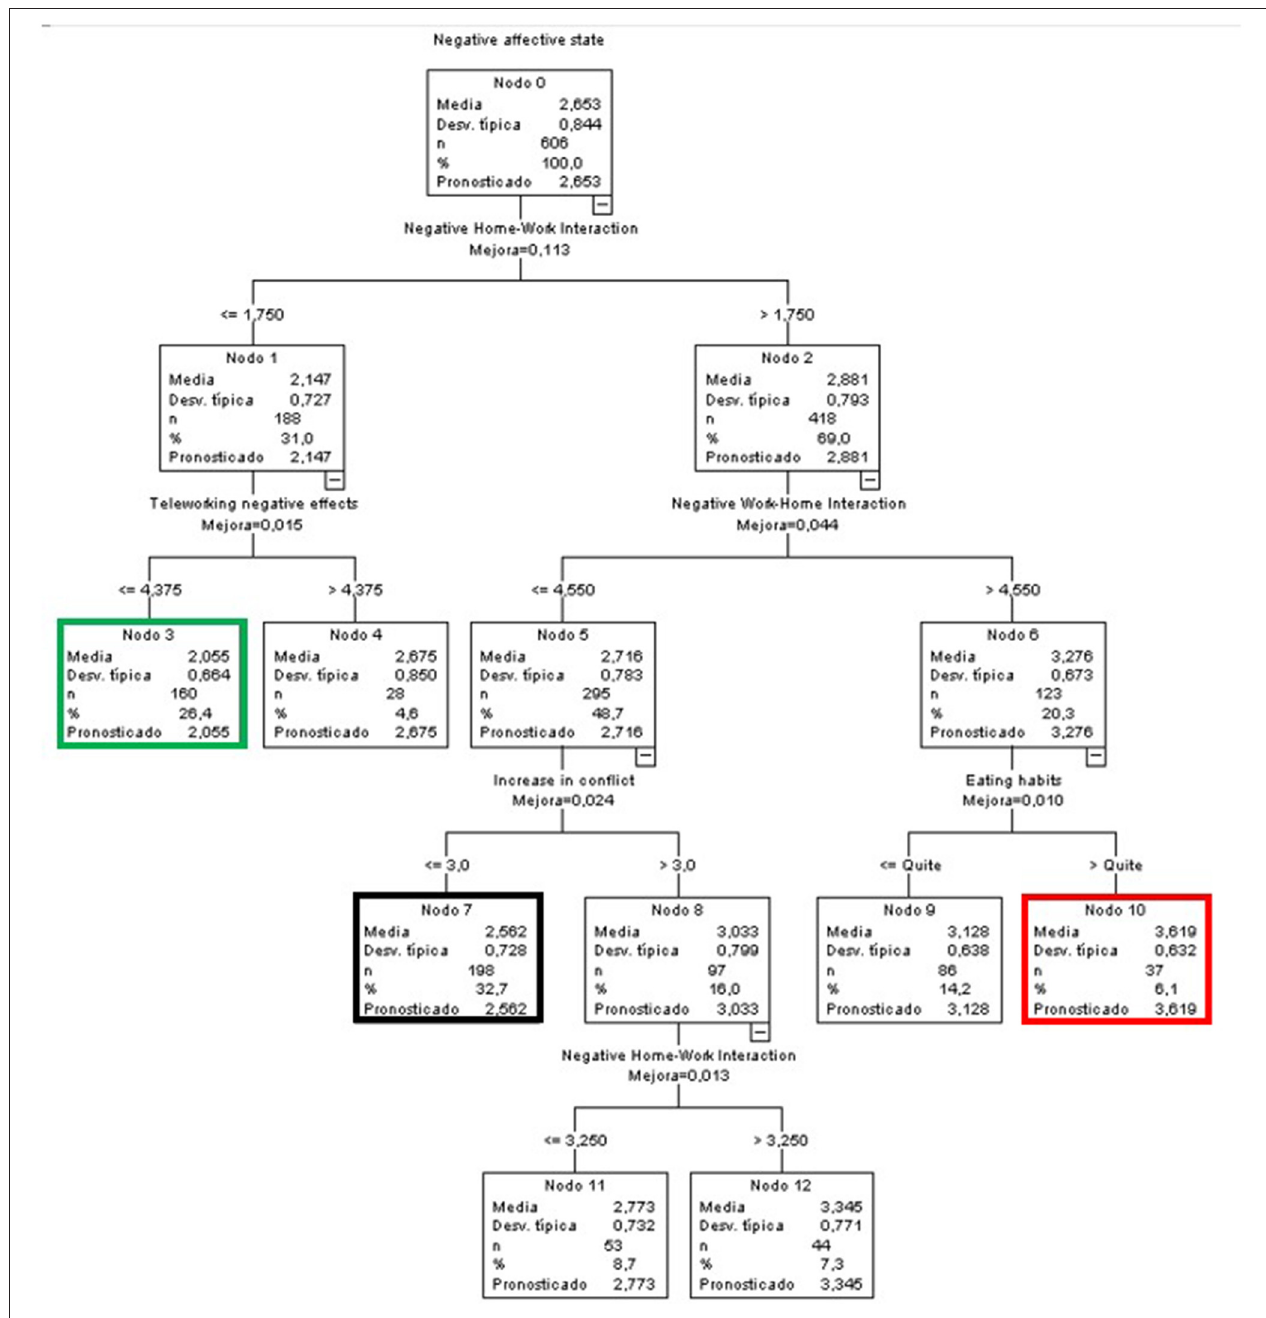
FIGURE 4 | Classificatory tree of negative affective states (Students).